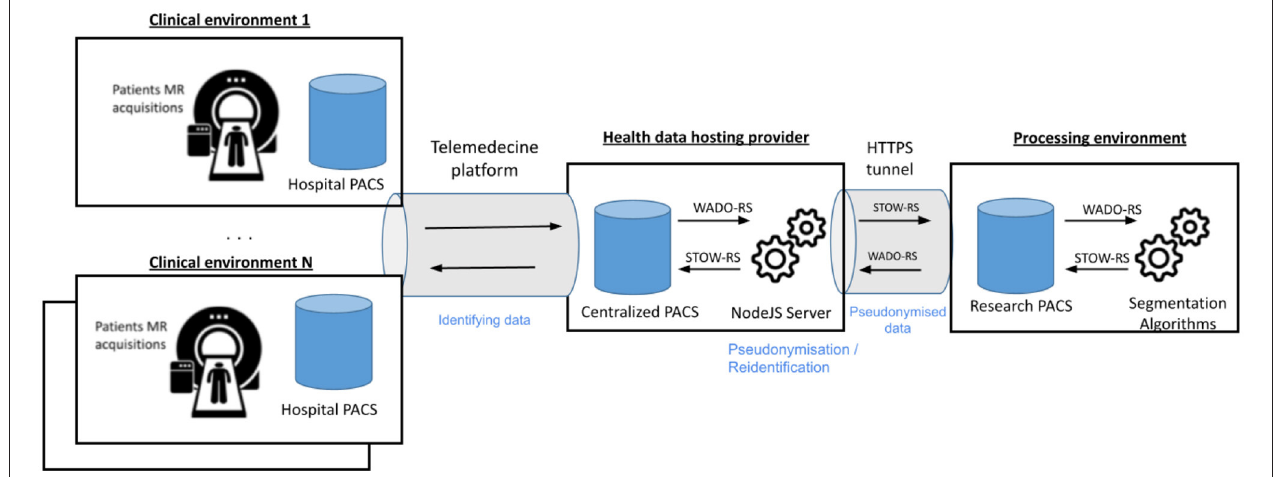
FIGURE 2 | Detailed architecture and interconnections in the MUSIC network. The system is composed of 2 main interconnected PACS (the centralized and the research PACS). The centralized PACS is interconnected to each connected hospital PACS to download the acquisitions to process and to upload the results. The research PACS is dedicated to data processing. The different connections are based on standardized HTTP requests (DICOMweb TM ) and are secured by an HTTPS